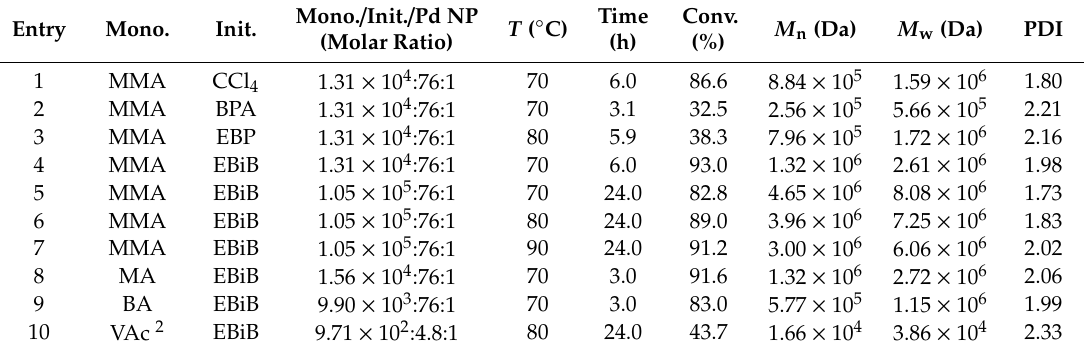
Table 1. Bulk polymerizations of methyl methacrylate (MMA) and other vinyl monomers initiated by organic halides in the presence of Pd NPs 1 .